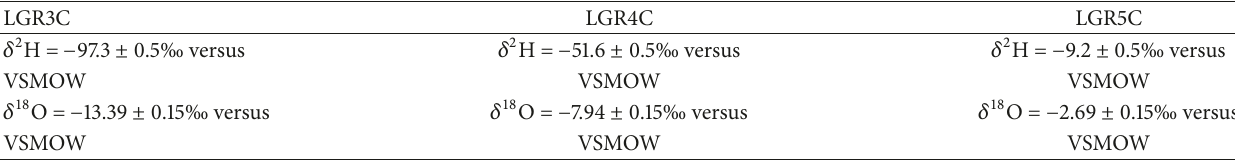
Table 1: The laboratory (LGR) standards and their assigned